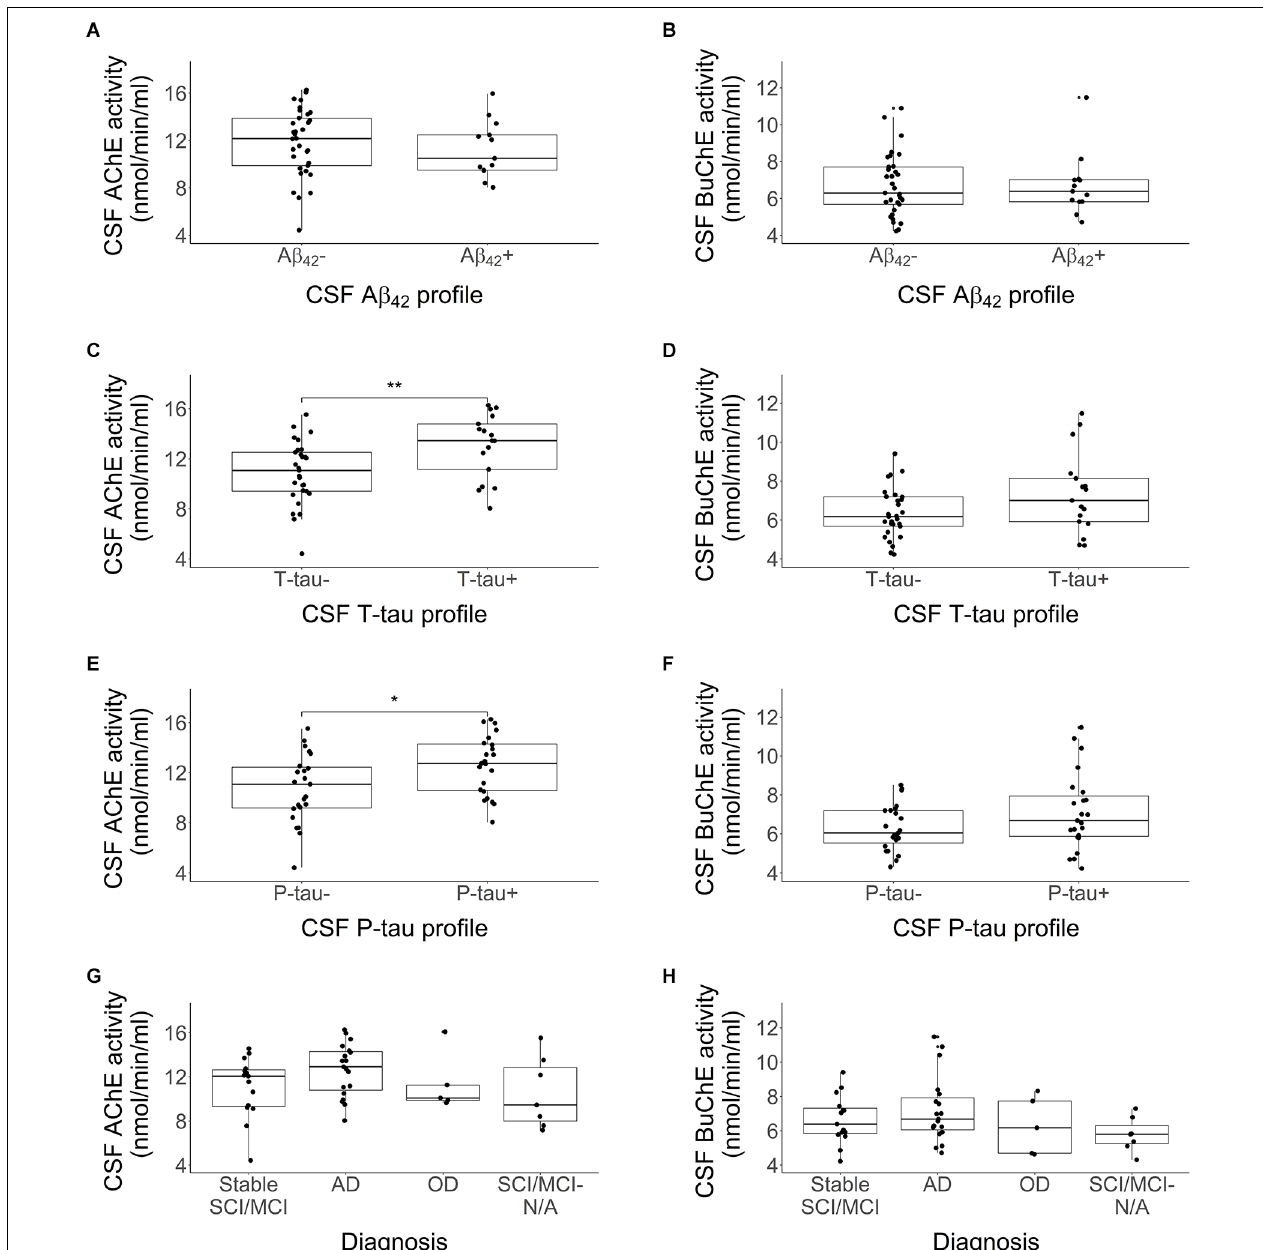
FIGURE 2 | Comparison in activity of CSF AChE and BuChE enzymes by CSF A β 42 profile (A,B) , T-tau profile (C,D) , P-tau profile (E,F) , and clinical diagnosis (G,H) , * p < 0.05, ** p < 0.01. Each profile was divided into two categories, abnormal (+) and normal (-) values. Abnormal values were defined as A β 42 < 375 pg/ml, T-tau > 445 pg/ml and P-tau > 61 pg/ml. The lower and upper horizontal lines of the boxplot correspond to the 25th centile and 75th centile and the middle line to the median. CSF AChE activity was significantly higher among subjects with a CSF T-tau+ or P-tau+ profiles compared to those without.